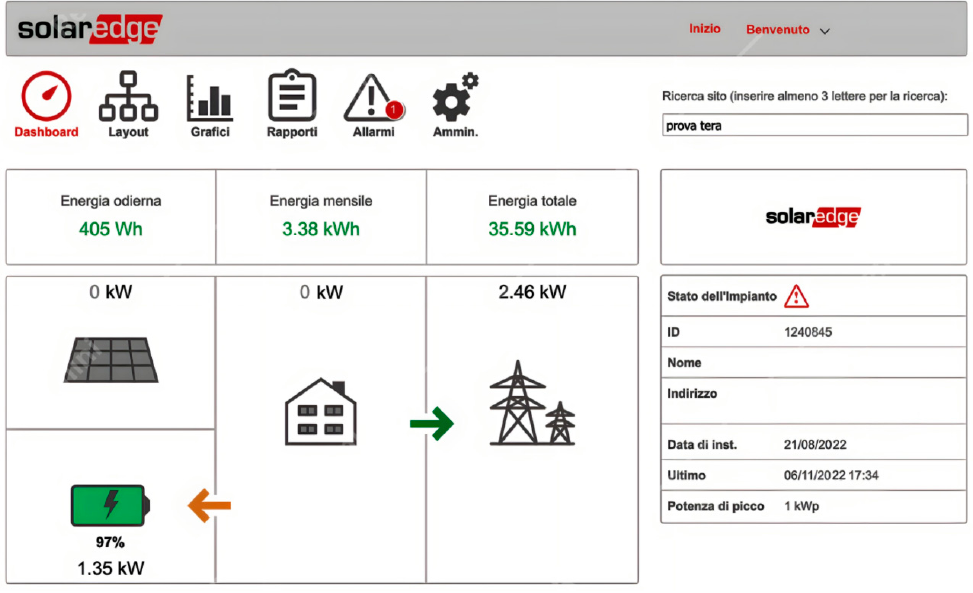
Figure 14. SolarEdge